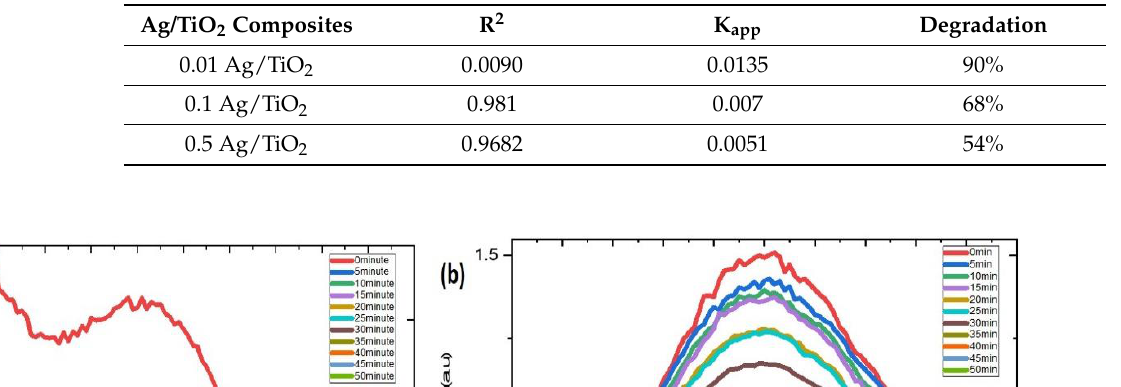
Table 2. Kinetics study of photocatalytic degradation of methylene blue.